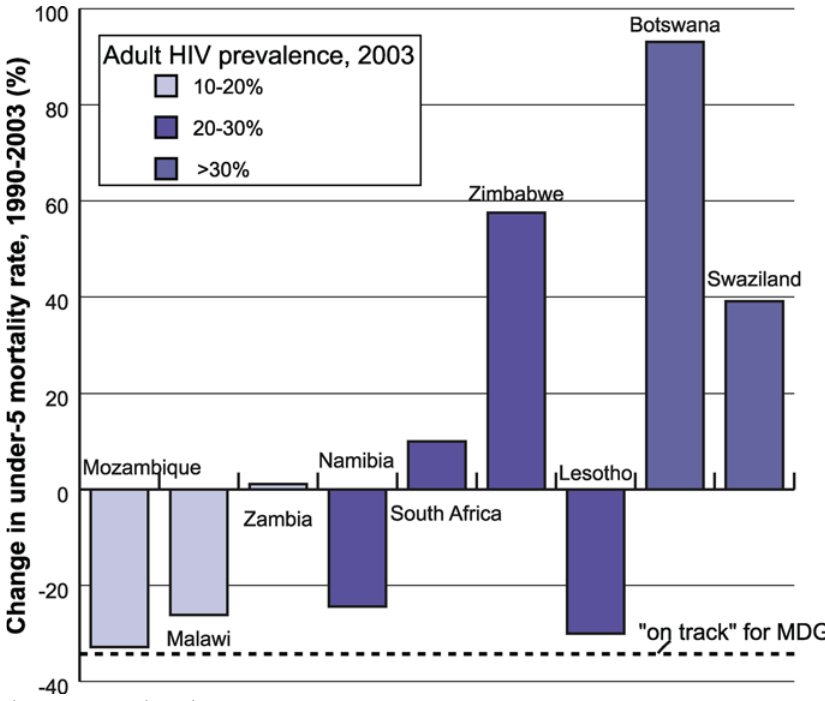
Figure 4. Change in Under-Five Mortality Rate in Select Countries with High HIV Prevalence, 1990–2003 Figure derived from